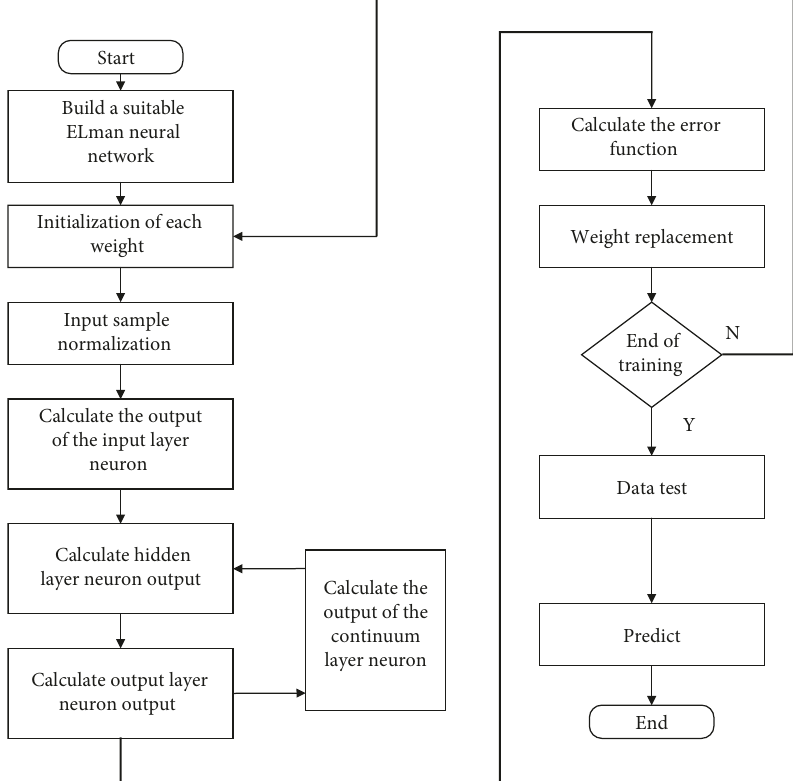
Figure 4: Forecast flow chart of the Elman neural network.